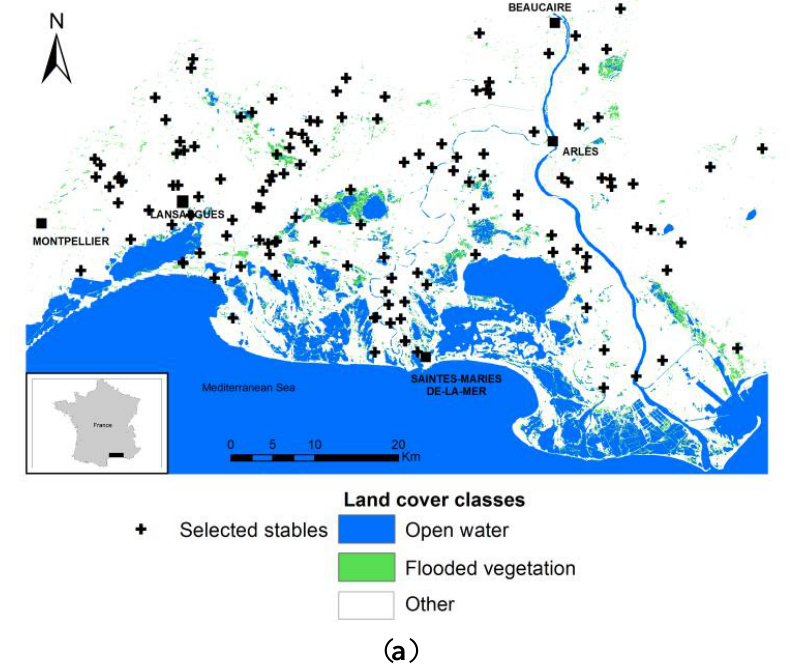
Figure 2. ( a ) Classification of a Landsat Image of the NOT period (11 January 2007); ( b ) Classification of a Landsat Image of the END period (17 April 2007); ( c ) Classification of a Landsat Image of the EPI period (8 September